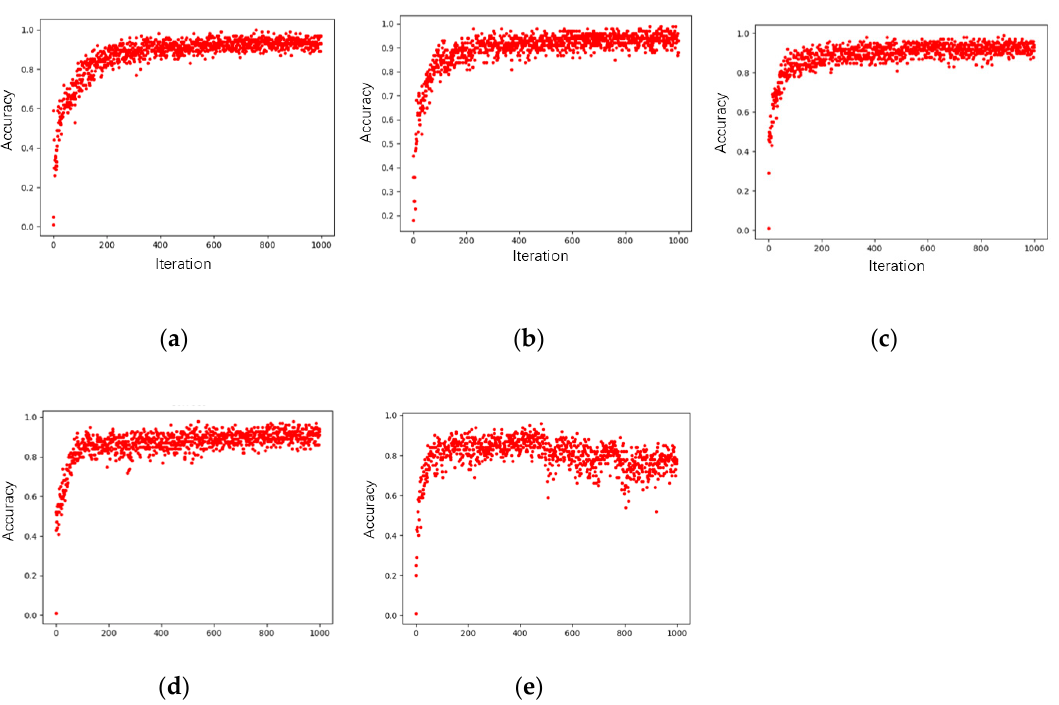
Figure 4. Accuracy rates with different learning rates. ( a ) Accuracy rates with a learning rate of 0.001; ( b ) accuracy rates with a learning rate of 0.003; ( c ) accuracy rates with a learning rate of 0.005; ( d ) accuracy rates with a learning rate of 0.007; ( e ) accuracy rates with a learning rate of 0.009. Table 2. Comparison of accuracy with different learning rates.